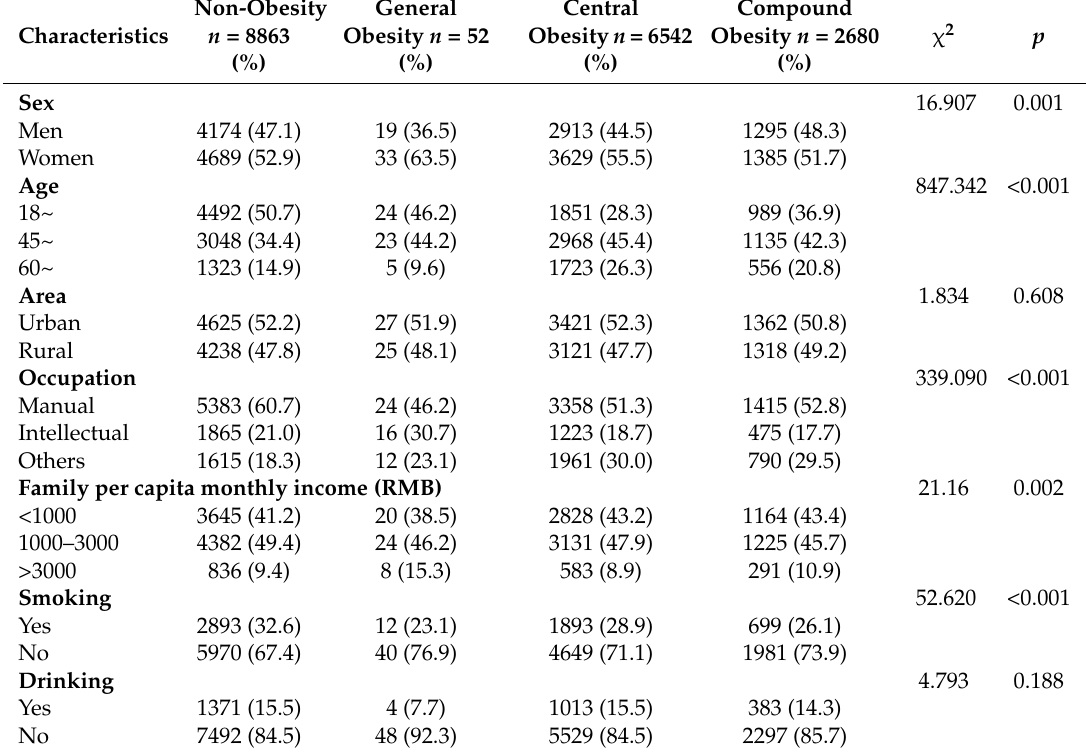
Table 1. Main characteristics of study population and the prevalence of obesity.